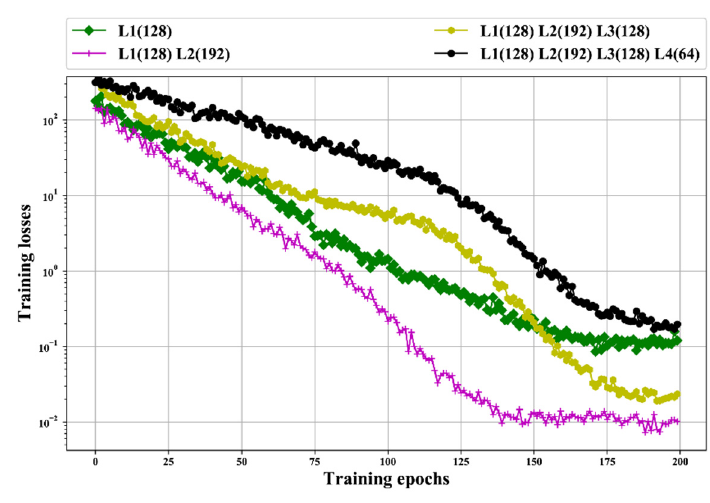
Figure 10. Loss curves in semi-log coordinate with the best structure and the lowest final loss in each group.